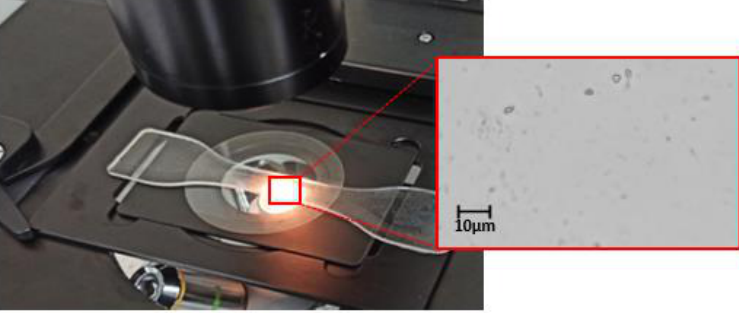
Figure 1. Bubbles measurement in the specimen.